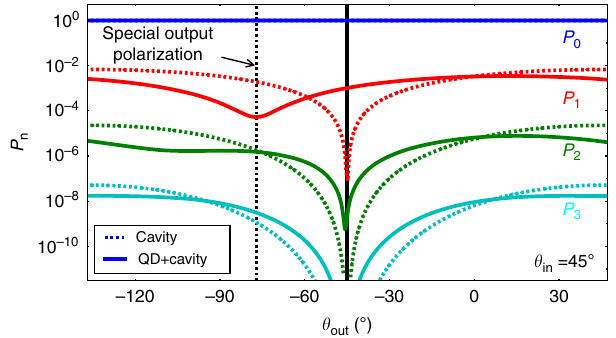
Figure 5 | Photon number distributions. Calculated photon number distribution after the polarizer, with (through curves) and without (dashed curves) coupling to the QD in the cavity, the laser frequency is set to one of the QD resonances. With QD, we clearly see the photon-number- dependent shift of the transmission dip. Only the photon number distribution of the detected polarization component is shown; therefore, the total number of photons in case with QD can exceed the case without QD due to polarization conversion by the dot. For clarity, pure dephasing has been neglected here, making the special polarization angle different from the other simulations and experimental